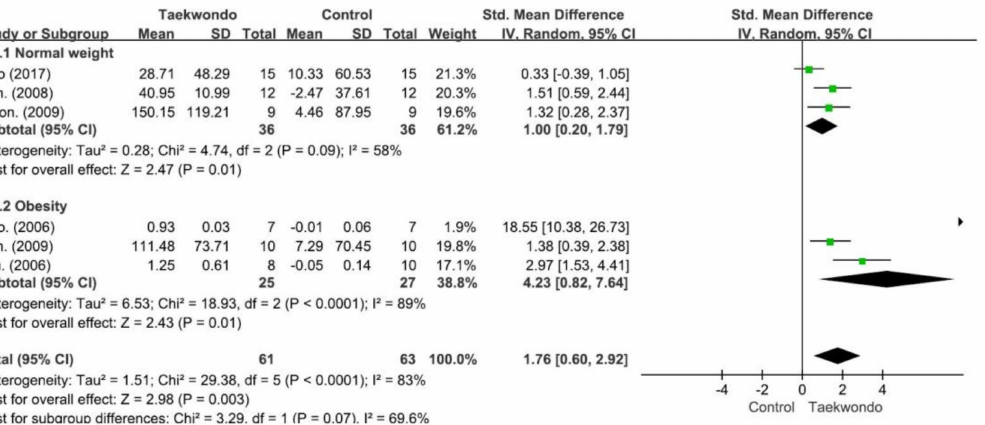
Figure 4. Forest plot depicting differences in the change-from-baseline insulin-like growth factor-1 levels between the taekwondo and control groups. CI: confidence interval and SD: standard